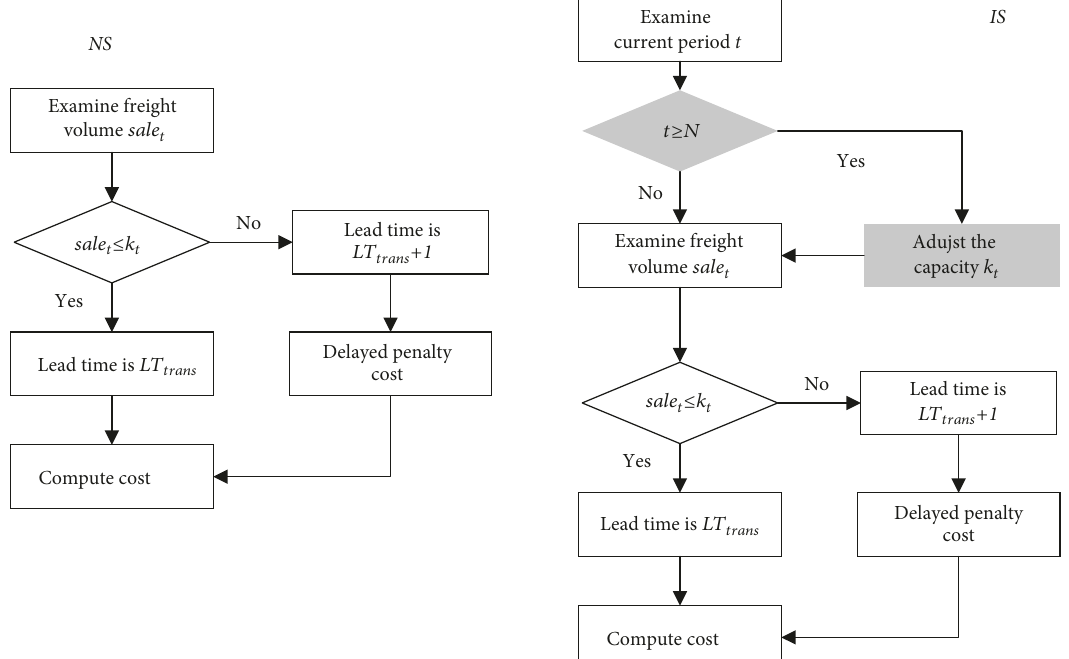
Figure 4: The carrier’s behavior under two strategies.